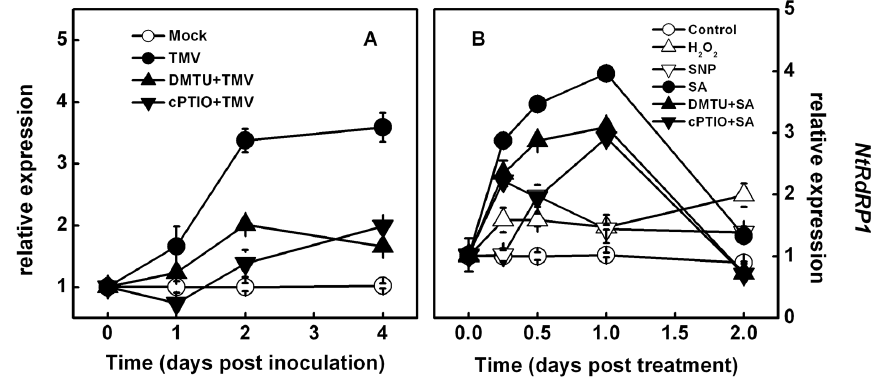
Figure 2. Effects of TMV infection, SA, and different chemical pretreatments on NtRDR1 transcripts. A . Changes in TMV-induced NtRDR1 transcript levels over time in non-inoculated upper leaves induced by hydrogen peroxide (H 2 O 2 ) and nitric oxide (NO) scavengers. The non-inoculated upper leaves were subjected to DMTU (H 2 O 2 scavenger) or cPTIO (NO scavenger) pretreatment 12 hours before TMV inoculation. B . Changes in SA- induced NtRDR1 transcript levels over time caused by exogenous H 2 O 2 , NO, and their scavengers. The results are expressed as the mean 6 SD, n = 4.